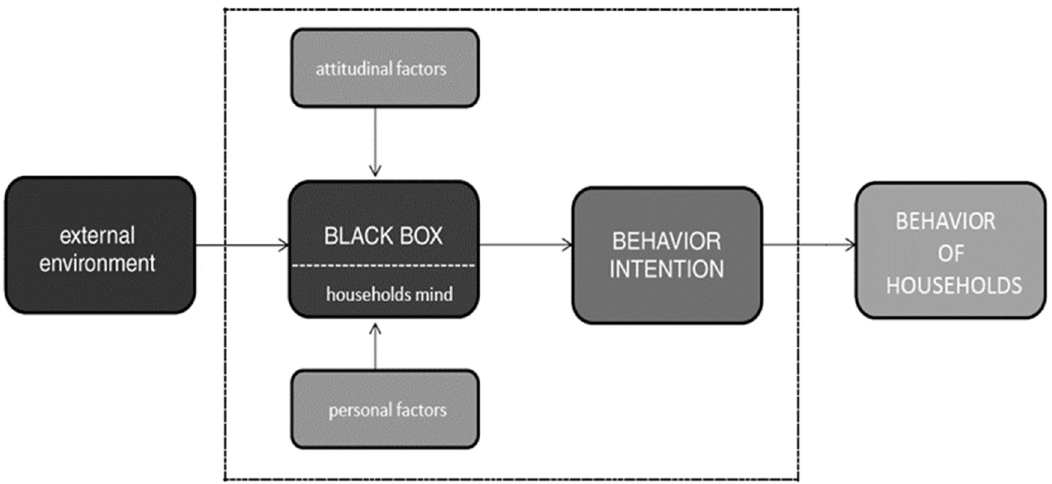
Figure 1. Conceptual model relating various internal and external factors to behavior of households.